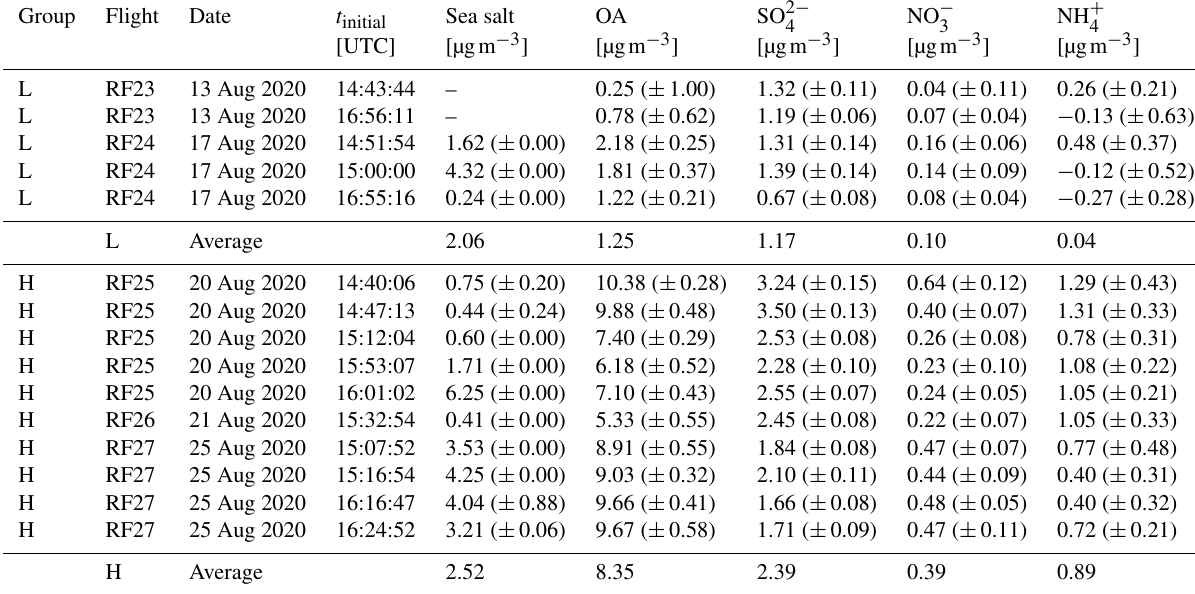
Table 4. All pairs’ aerosol composition below cloud base (BCB) during the August 2020 deployment. Mean values and standard deviation in parentheses for organic aerosol (OA), SO 2 − measurements are given at standard temperature and